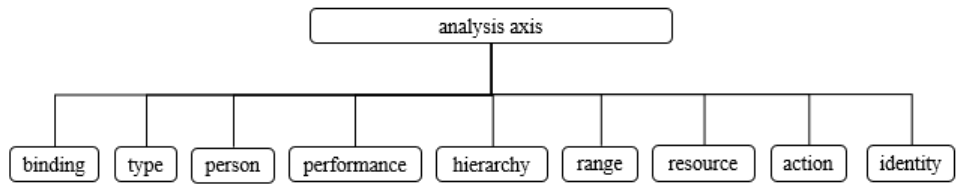
Figure 1. The analysis axis.